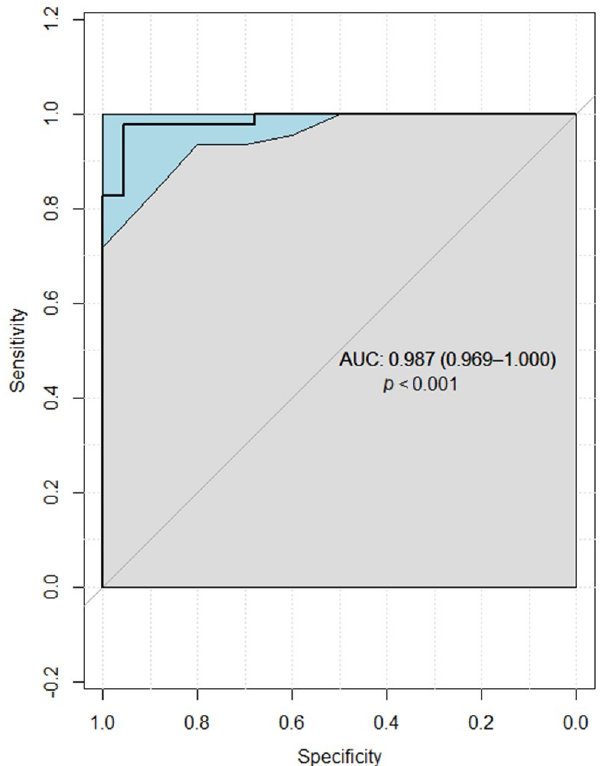
Figure 5. ROC analysis of predicting CKD after radical nephrectomy. Abbreviations: AUC—area under the curve.